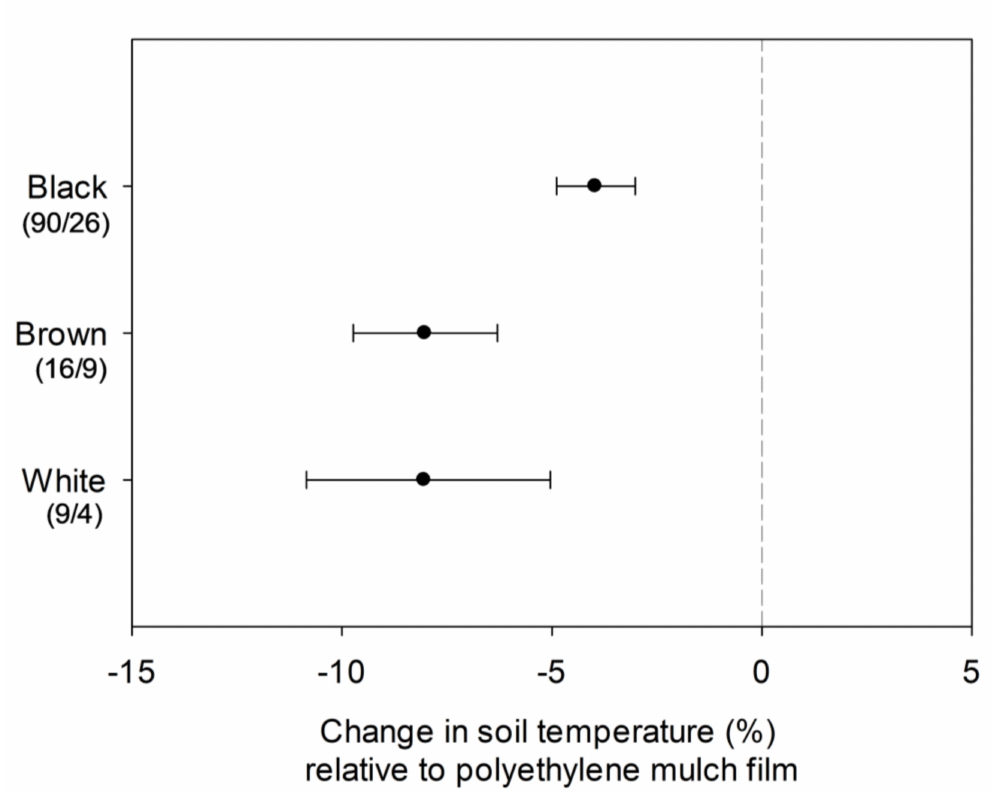
Figure 3. Mean change in soil temperature as influenced by biodegradable mulch color (relative to black polyethylene mulch film). Numbers below y-axis labels indicate the number of observations and studies (left / right, respectively) contributing to each mean. Error bars represent 95% confidence intervals determined via